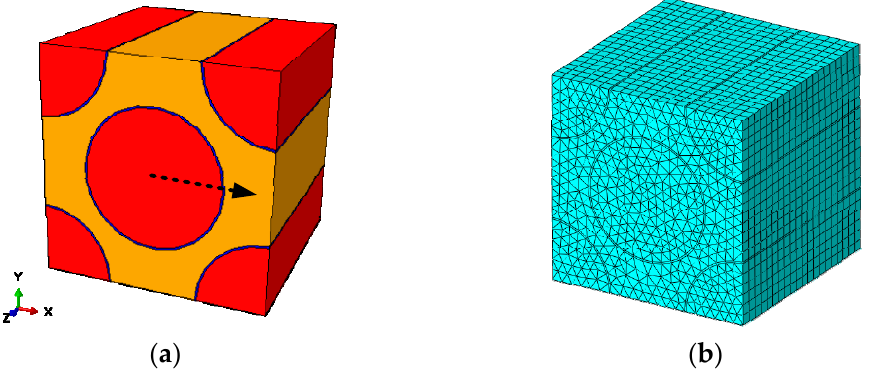
Figure 3. Fiber diamond distribution microscale RVE considering interface. ( a ) geometrical model; ( b ) finite element model.